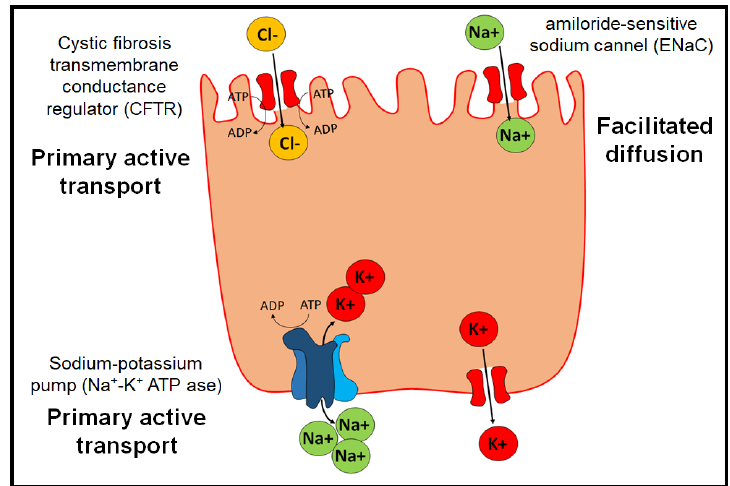
Figure 3. Physiological transporters that prevent edema in pulmonary alveoli.